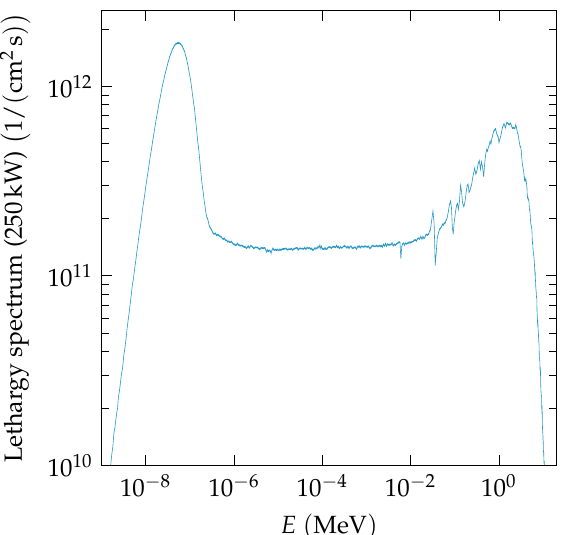
Figure 1. Lethargy neutron spectrum of channel F19 in Core 189 of the JSI TRIGA reactor used for all our neutron irradiations, at full reactor power (250kW)